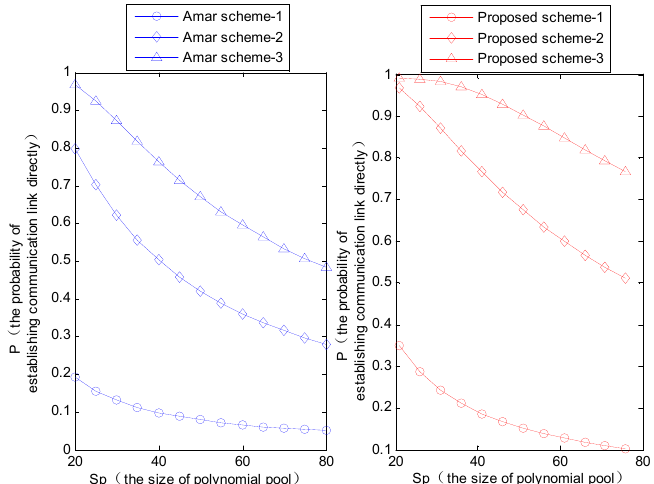
Figure 6. The probability that MS and sensor nodes directly establish the communication link in different size of polynomial ring and polynomial pool when q = 0.99.